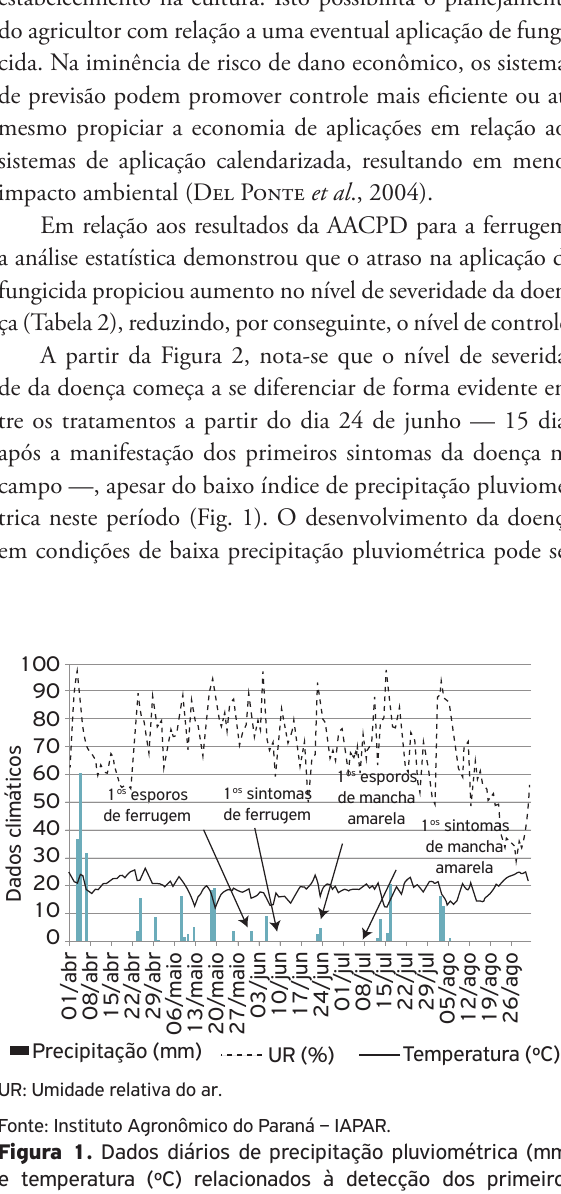
Figura 1. Dados diários de precipitação pluviométrica